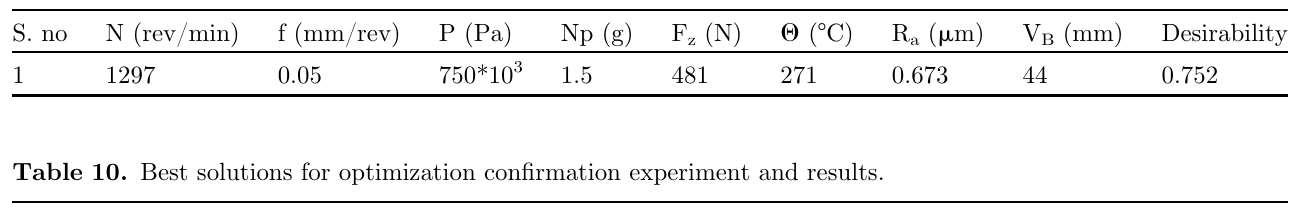
Table 9. Best solutions for optimization.